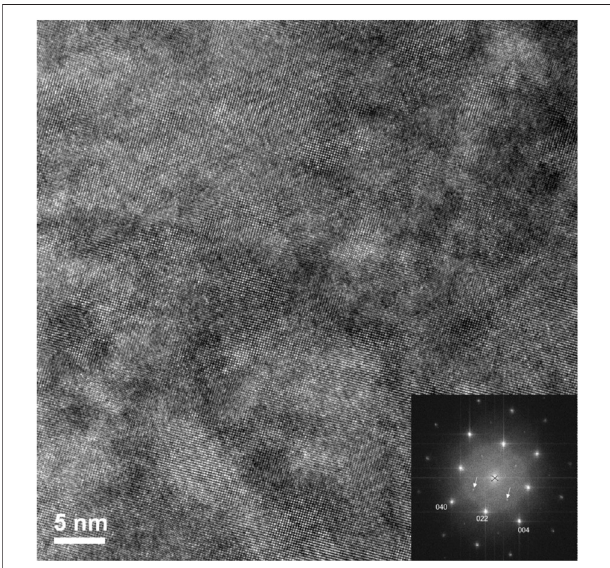
FIGURE 12 | Top of lift out area in Figure, showing highly ordered lattice fringes. The FFT inset of the high-resolution image is viewed down the [1 0 0] and shows a very small amount of diffuse scattering, possibly from amorphousmaterial.Superlatticere fl ectionsareindicatedbythearrows.